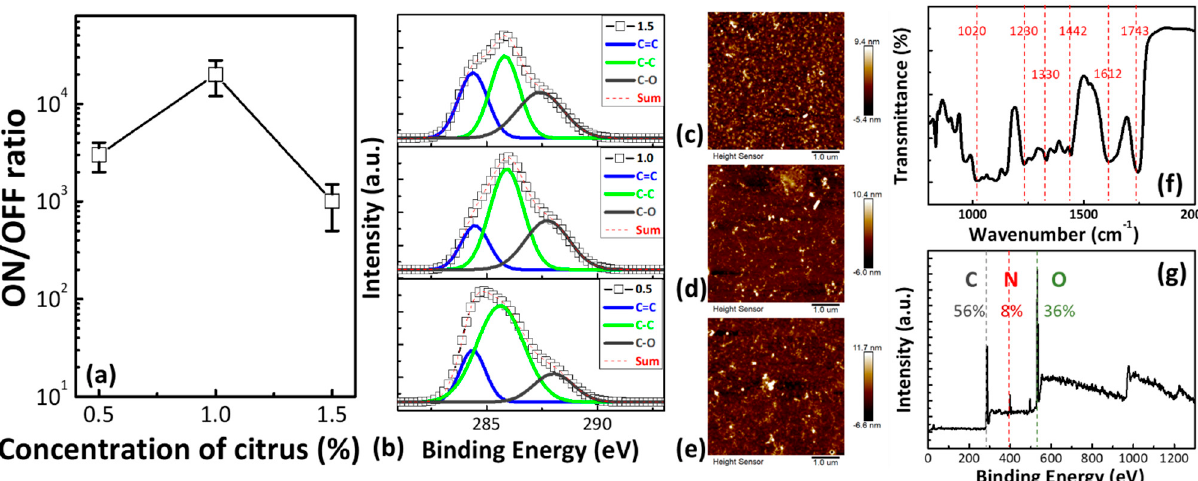
Figure 1. ( a ) The ON/OFF ratio as a function of the citrus concentration. ( b ) XPS C 1s spectra of the citrus thin film: C0.5 (bottom), C1 (middle), and C1.5 (top). Tapping mode 2D and 3D AFM topography images of ( c ) C0.5, ( d ) C1, and ( e ) C1.5 thin films. ( f ) FTIR analysis, and ( g ) XPS full spectrum analysis of the C1 thin film.